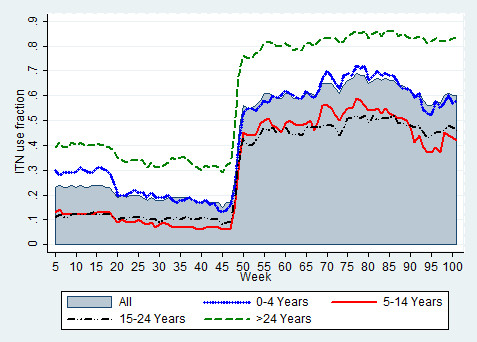
Insecticide-treated bed net use fraction by age group.